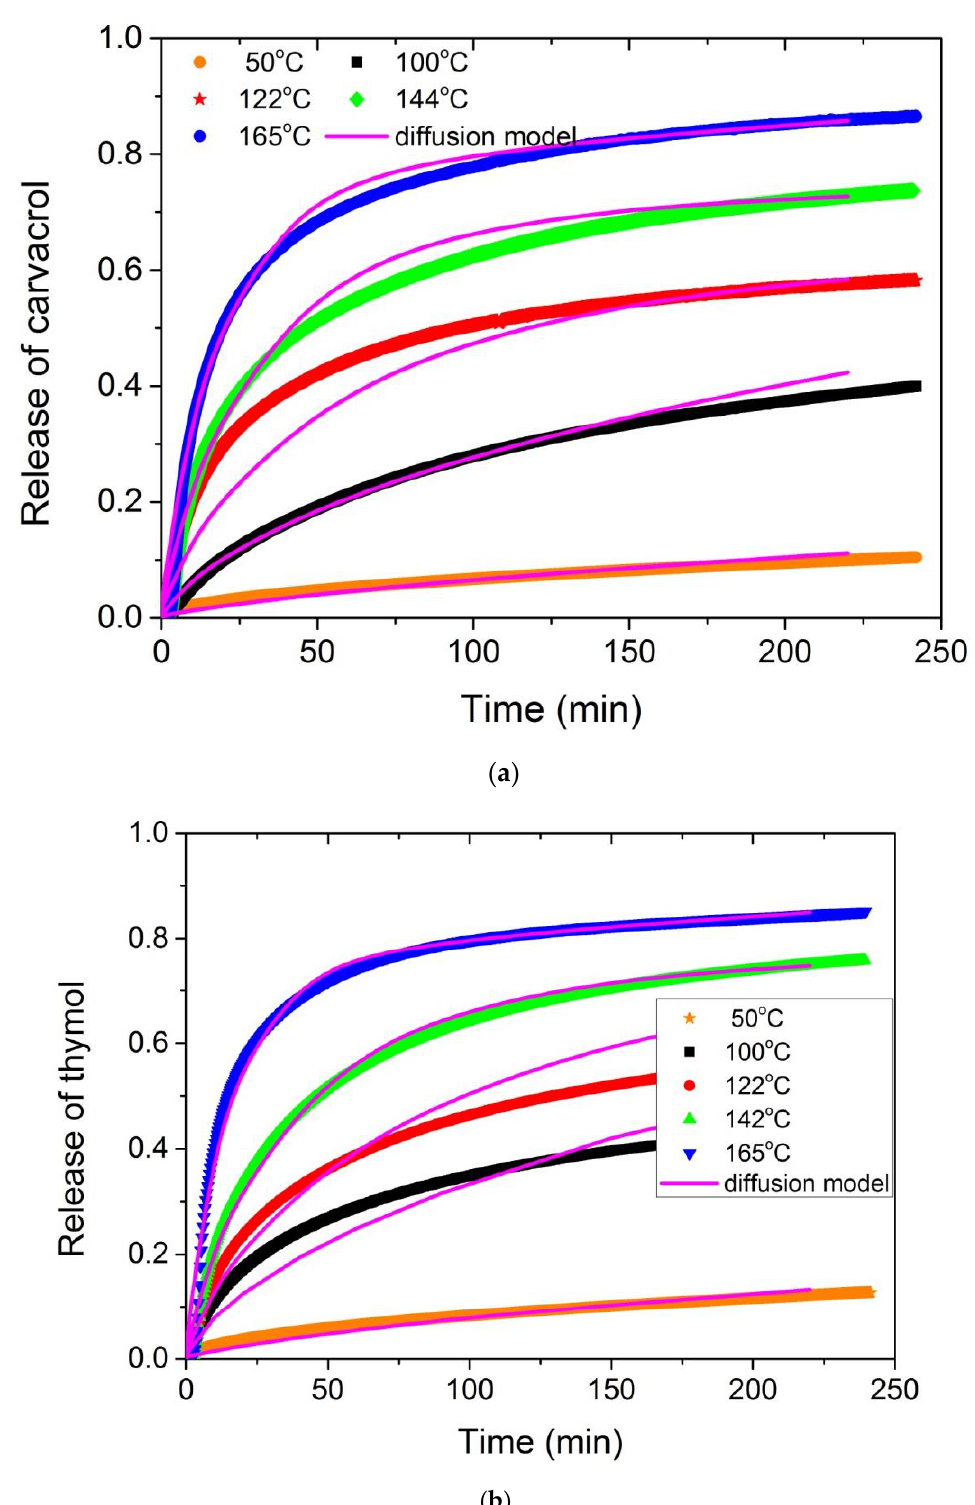
Figure 11. Comparison of the simulation results obtained from the combined diffusion model (Equation (10)) and the best-fit parameters shown in Table 4, to the normalized isothermal TGA experimental data plotted in the form of M t /M ∞ obtained at different temperatures, for carvacrol ( a ) and thymol ( b ).